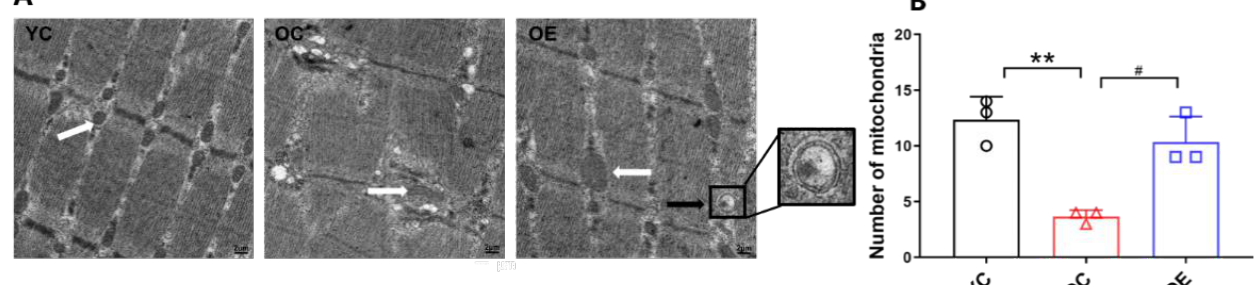
Figure 2. Lifelong aerobic exercise repaired the damaged mitochondria in skeletal muscle fibers during the aging process. ( A ) Representative images of gastrocnemius muscles of the mice from each group (8000 × ) observed by TEM; white arrows: mitochondria; black arrows: autophagosomes. ( B ) The number of mitochondria was counted from randomly selected images of 3 skeletal muscle samples from each group. All data are presented as mean ± standard deviation (M ± SD) ( n = 3 mice per group). Group symbols: YC, black circle; OC, red triangle; OE, blue square. ** p < 0.01 vs. YC group; # p < 0.05 vs. OC